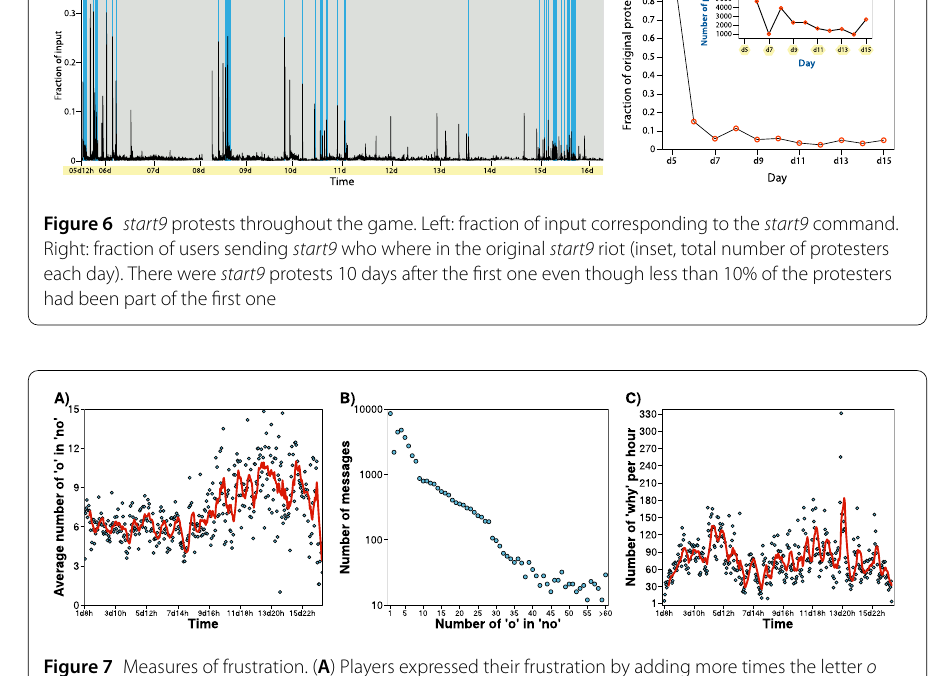
Figure 7 Measures of frustration. ( A ) Players expressed their frustration by adding more times the letter o when they wanted to say no . Even though frustration was present throughout the event, it was incremented after the events of bloodySunday . ( B ) Distribution of the number of o . Interestingly, the relationship is not linear as the word noo tends to appear less than nooo or noooo , which indicates that when players were frustrated they overexpressed it. ( C ) Number of messages containing the word “why” per hour. This indicates that many players did not understand the movements of the crowd, which probably made them